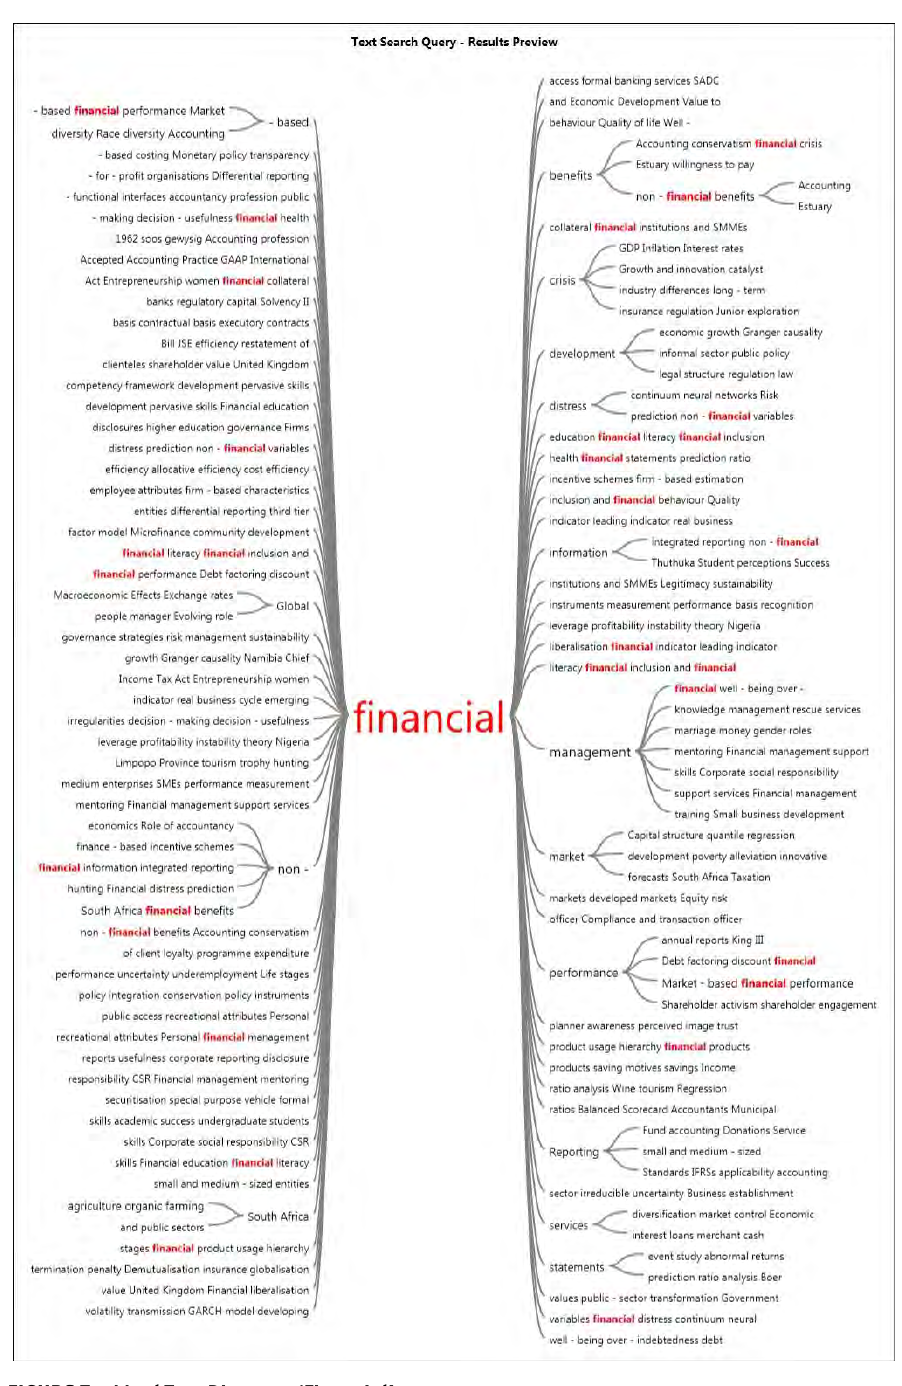
FIGURE 7: Word Tree Diagram: ‘Financial’